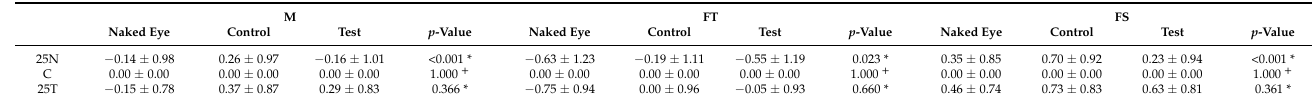
Table 2. Mean ± standard deviation of the relative values of M, FT, and FS for the three points measured (25N, C and 25T), for the naked eye condition, and the control and test conditions. The p -value refers to the differences between control and test conditions.